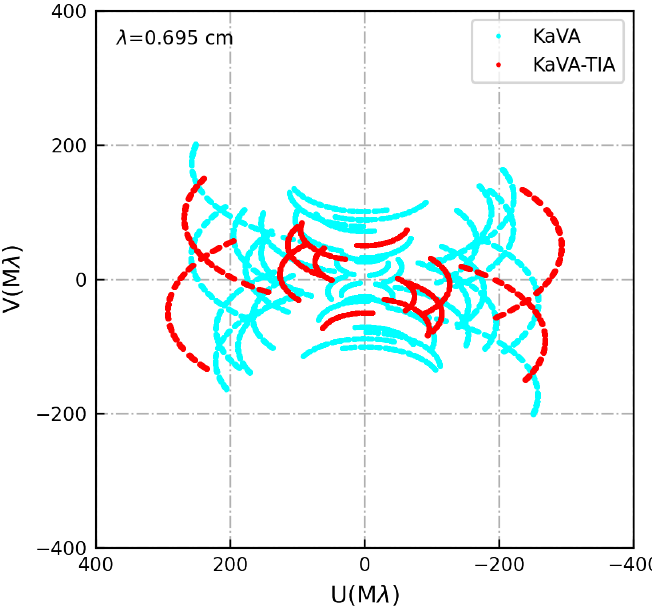
Figure 1. Typical u − v coverage of EAVN observations (a19kh01c) at 43 GHz. Each point has been averaged within 30 s. TIA provides the longest baselines (red points) in an east-west